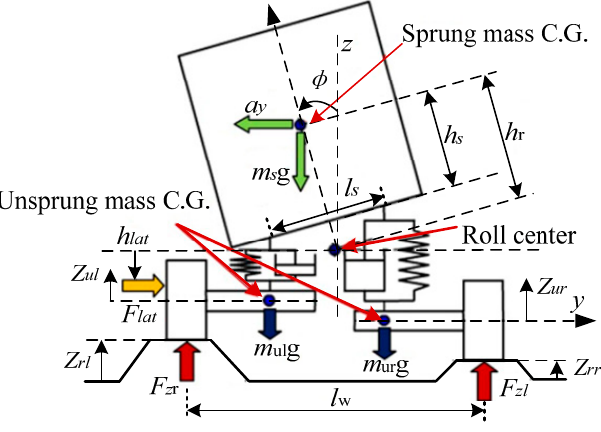
Figure 4. Roll behavior of vehicle system.